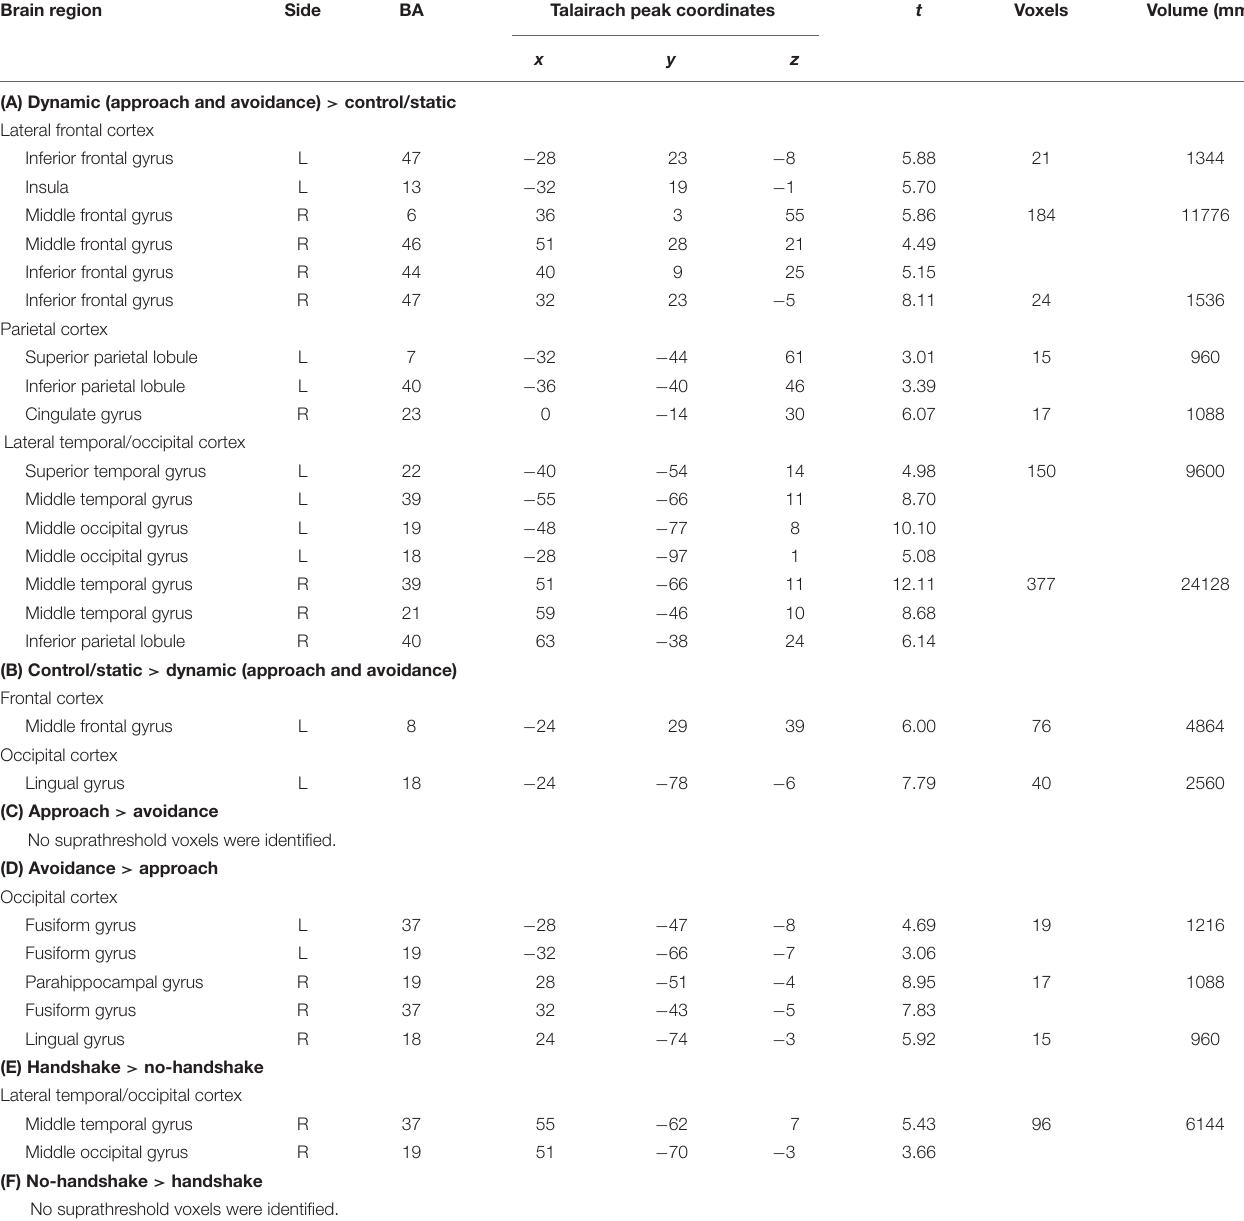
The table identifies a network of brain regions showing main effects of behavior and handshake, as revealed by a 3 (Behavior) × 2 (Host Race) ANOVA and a 2 (Handshake) × 2 (Host Race) ANOVA, respectively. These F-contrast maps were used to inclusively mask the corresponding T-contrast maps to further identify the directionality of BOLD activation. All clusters reported in this table meet the significance threshold determined based on a Monte Carlo simulation, corrected for multiple comparisons at p < 0.05 (see section “Materials and Methods”). BA, Brodmann’s area; L, left; R, right. regarding the dissociable neural correlates of observing ingroup vs. outgroup social